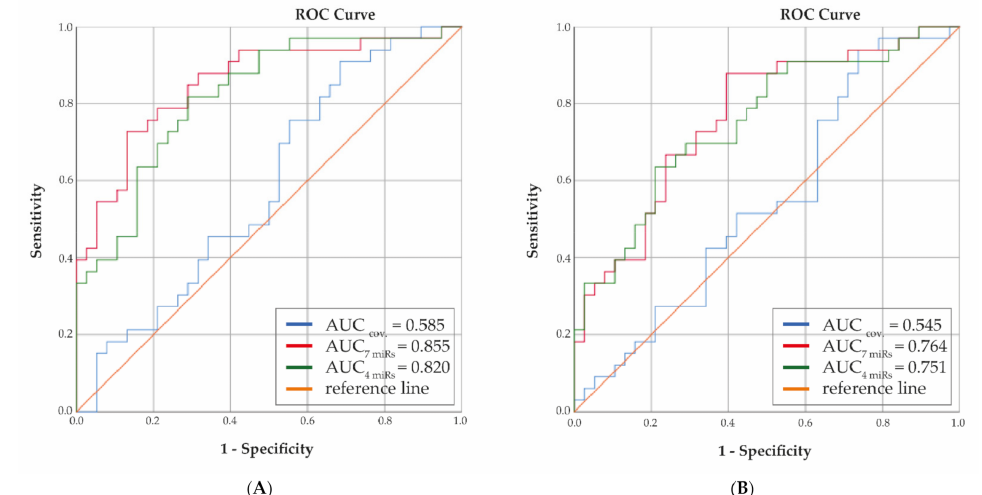
Figure 4. Receiver Operator Curve predictive value of selected plasma miRNAs at 2 ( A ) and 5 years ( B ) follow-up (sex, age, and BMI only: blue line; including 7 miRNAs (miR-1307-5p, miR-140-3p, miR- 181a-3p, miR-221-5p, miR-4326, miR-4443, miR-99a-5p): red line; including 4 miRNAs (miR-1307-5p, miR-181a-3p, miR-4326, miR-4443): green